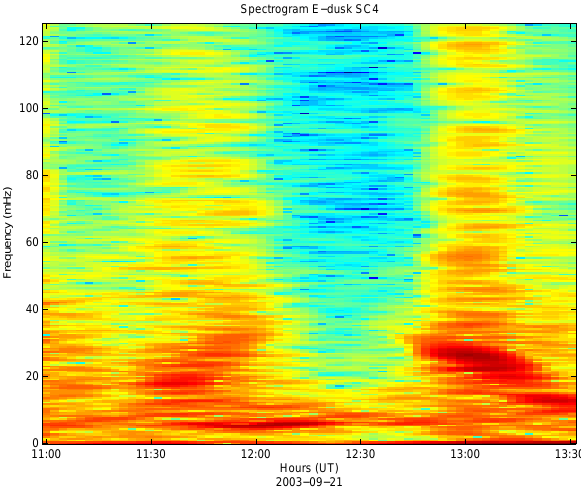
Fig. 9. L -value, polar angle in SM-coordinates and MLT for s/c 1, s/c 2, s/c 3 and s/c 4 for the 21 September 2003 event.